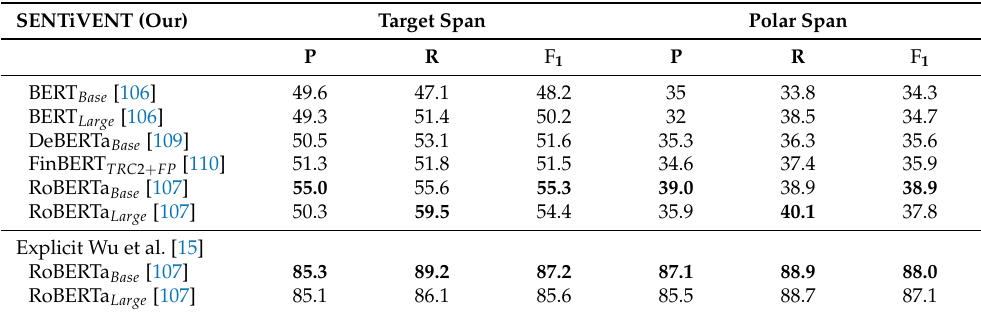
Table 10. Fine-grained aspect and polar span extraction results on holdout test set for winning models after optimizing hyperparameters for each architecture. Precision (P), recall (R), and F 1 -score (F 1 ) percentages are